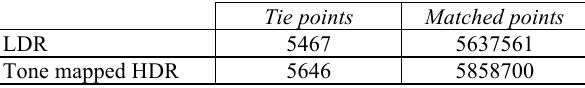
Table 6. Ceramic object #3 (dark Greek vase). Matching results for different image pre-processing and no polarizer filtering.